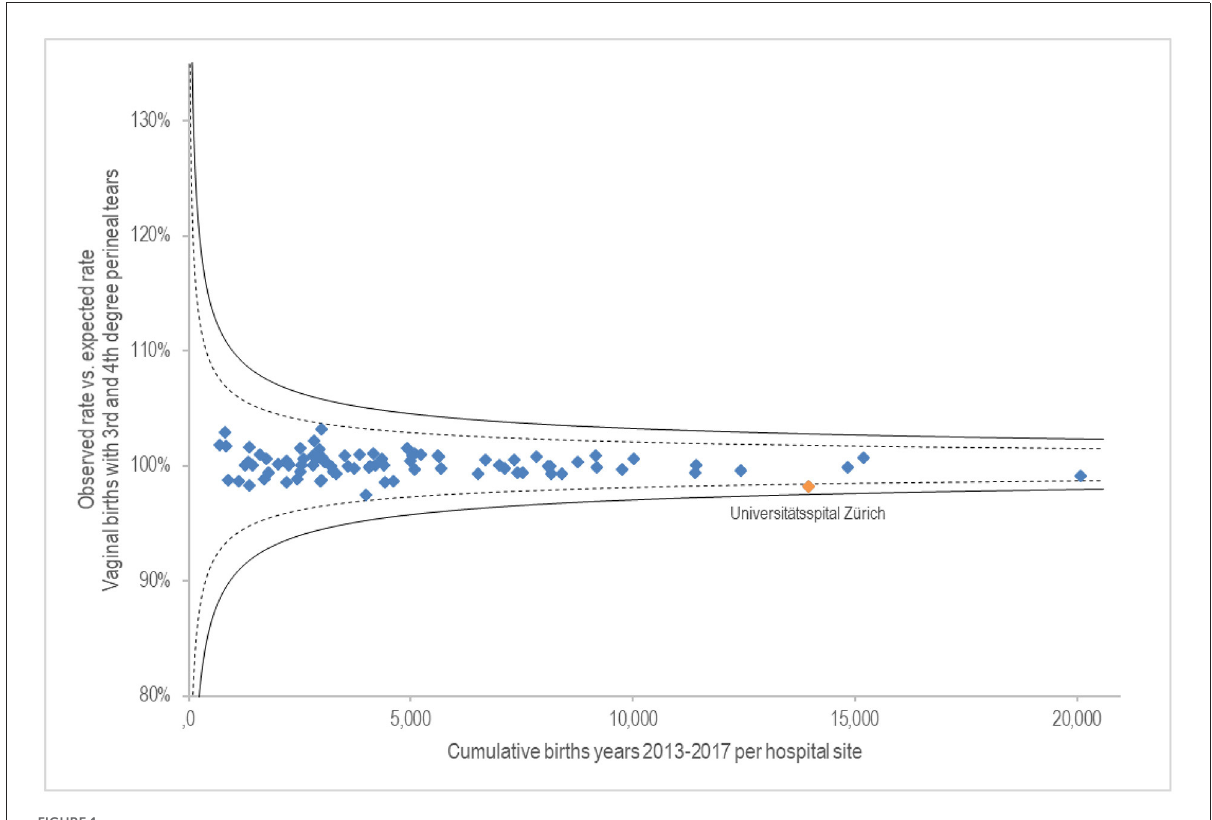
FIGURE1 G.1.2.P Proportion of vaginal births with perineal laceration of 3rd and 4th